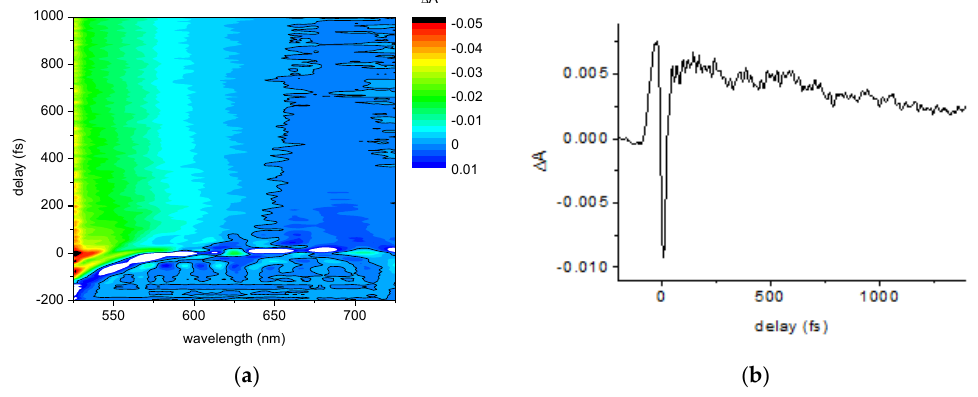
Figure 4. ( a ) Two dimensional view of the time-resolved absorption change spectra; ( b ) Time-resolved absorption change trace probed at 640 nm.